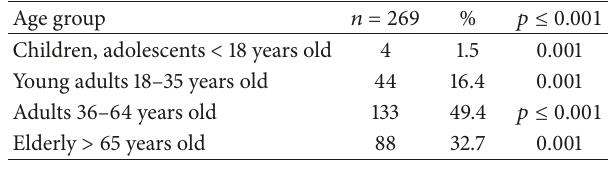
Table 1: Demographic data and 25 (OH)-D levels.